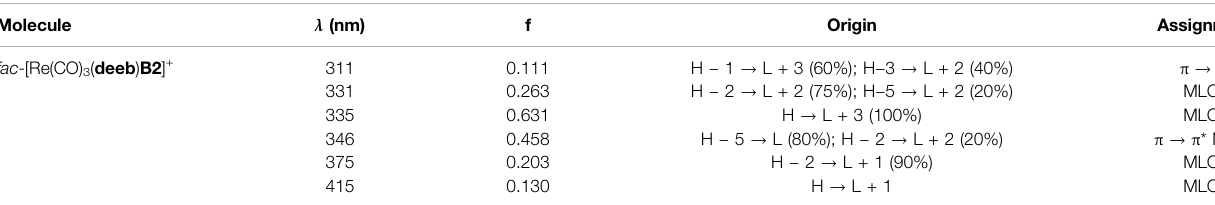
TABLE 3 | Calculated absorption bands considering the solvent effect (acetonitrile).